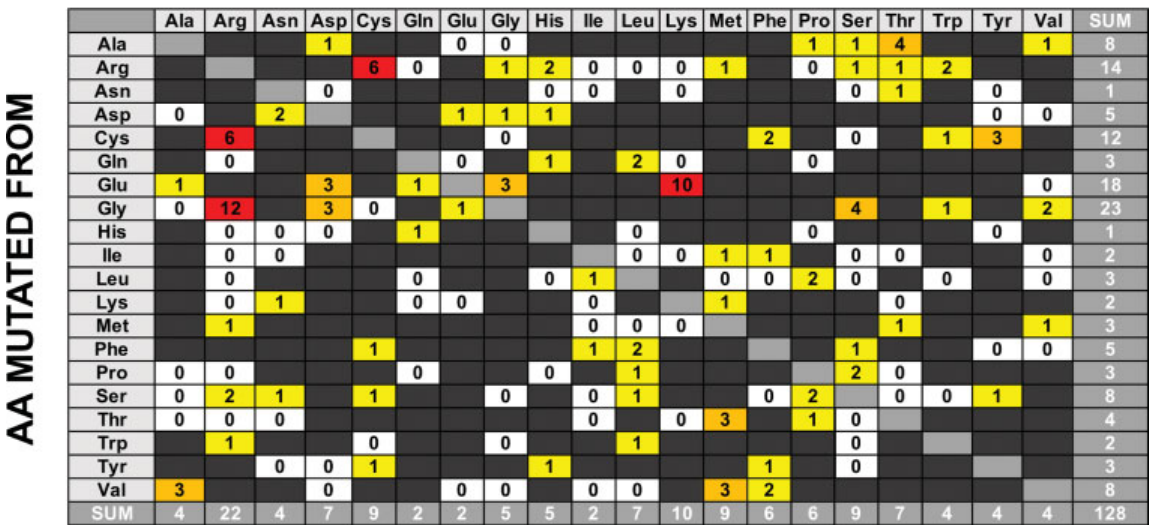
Fig. 5 Substitution grid representing 128 missense variants in the F10 gene. The grid illustrates the number of variants of each de fi ned amino acid change. All substitutions shown are the result of a single nucleotide change. Any substitutions that require more than a single nucleotide change are shown in dark gray. Silent variants are excluded from the grid and shown in pale gray. The white boxes represent possible substitutions that do not occur in the F10 gene. The yellow boxes represent substitutions that occur once or twice, the orange boxes represent substitutions that occur three or four times and the red boxes represent substitutions that occur fi ve or more